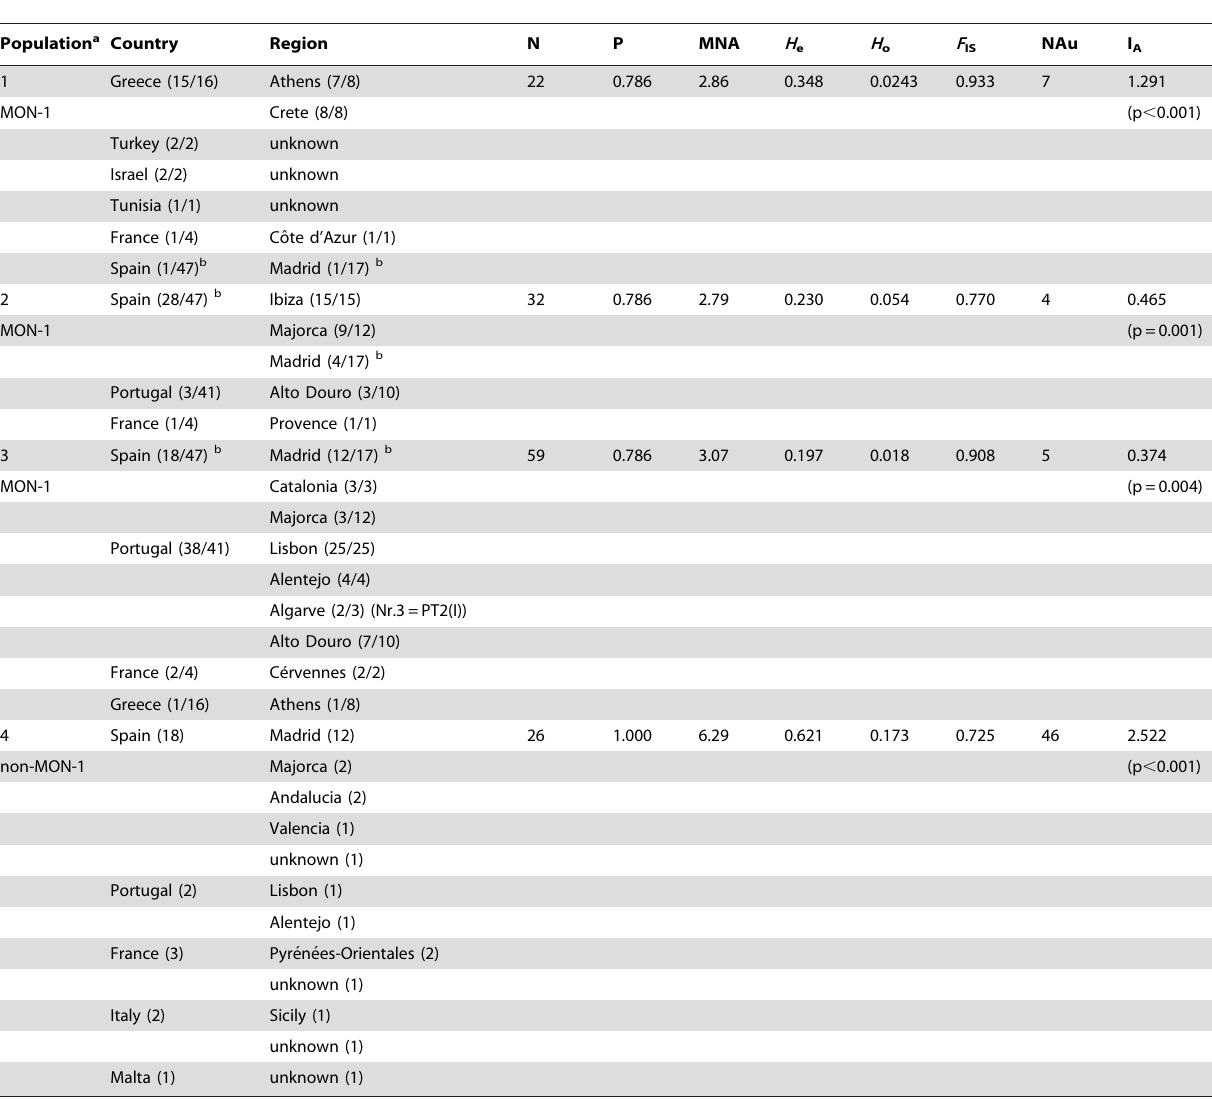
Table 7. Characterization of the 4 populations found by STRUCTURE ( K =4) analysis of 139 strains of Mediterranean L. infantum